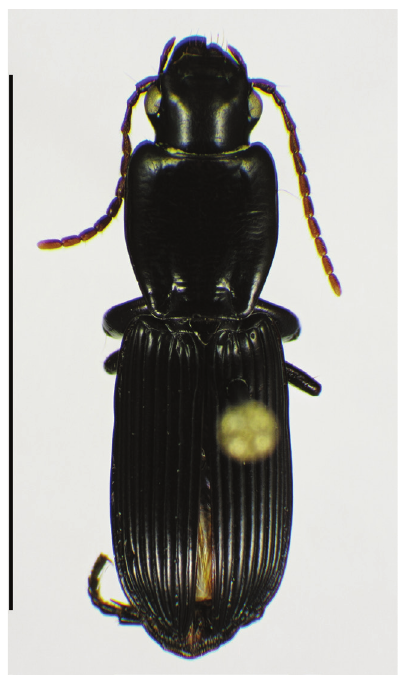
Figure 62. Habitus digital images of Stenomorphus californicus manni Darlington, dorsal aspect. Scale bar 10